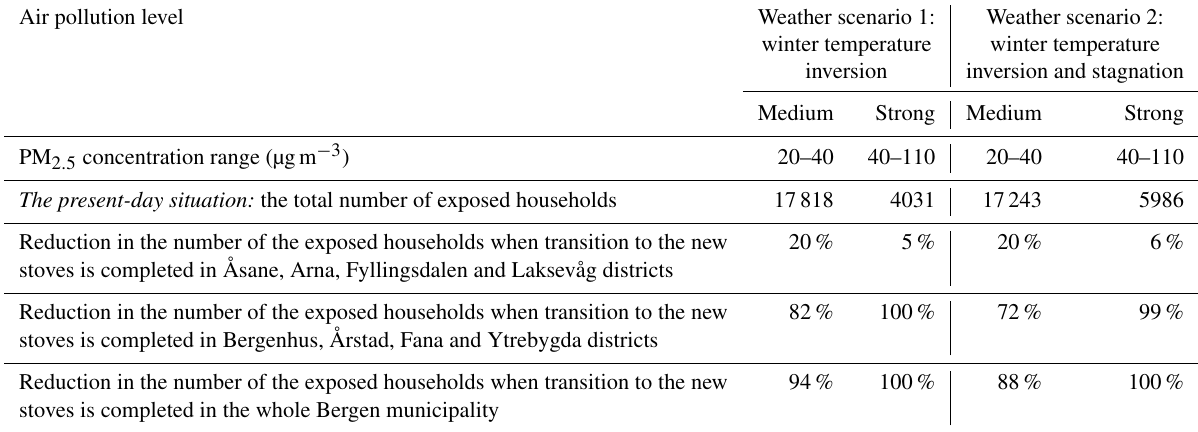
Table 1. Summary of the total simulated effect of the suggested mitigation